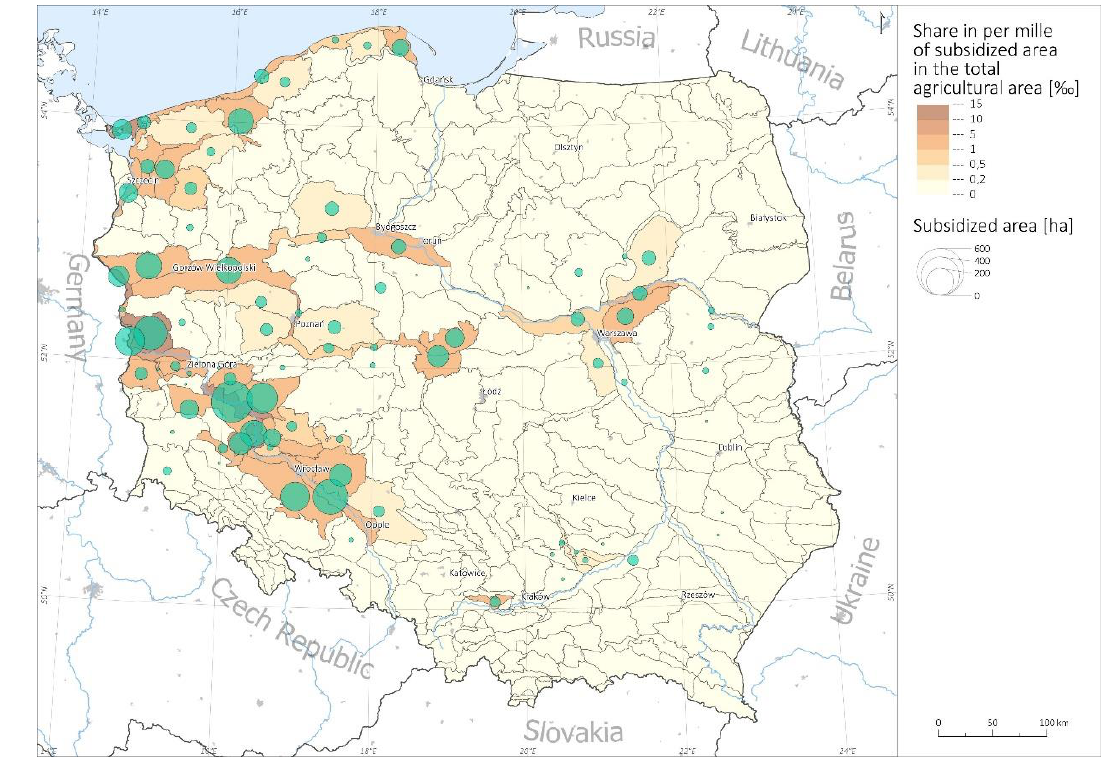
Figure 4. Area of land subsidised to support the protection of alluvial Cnidion meadows and salt marshes, and their share in the total area of agricultural land in mesoregions (Source: Authors based on ARMA data).